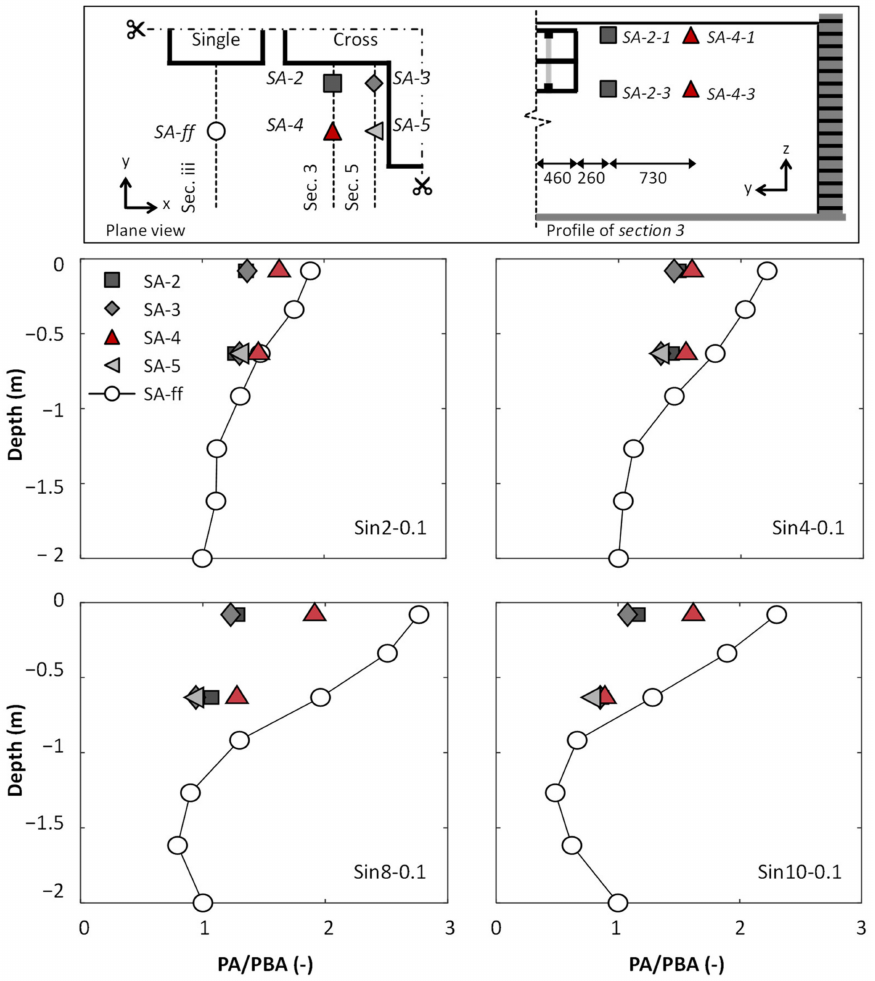
Figure 14. Amplification ratio of the peak acceleration (PA) to the peak base acceleration (PBA) as a function of the depth for the accelerometer arrays SA-2~SA-4 and SA-ff during all the tested sinusoidal motions, along with illustrations of the accelerometer